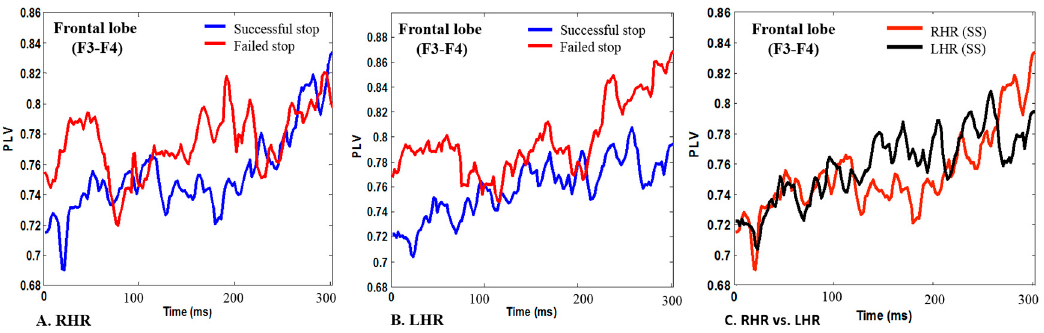
Figure 5. The PLVs were investigated during successful stop (SS) and failed stop (FS) trials in frontal lobe (F3-F4) of the brain. ( A ) The PLV during SS and FS trials in RHR; ( B ) The PLV during SS and FS trials in LHR; ( C ) The PLV during RHR (SS) and LHR (SS).